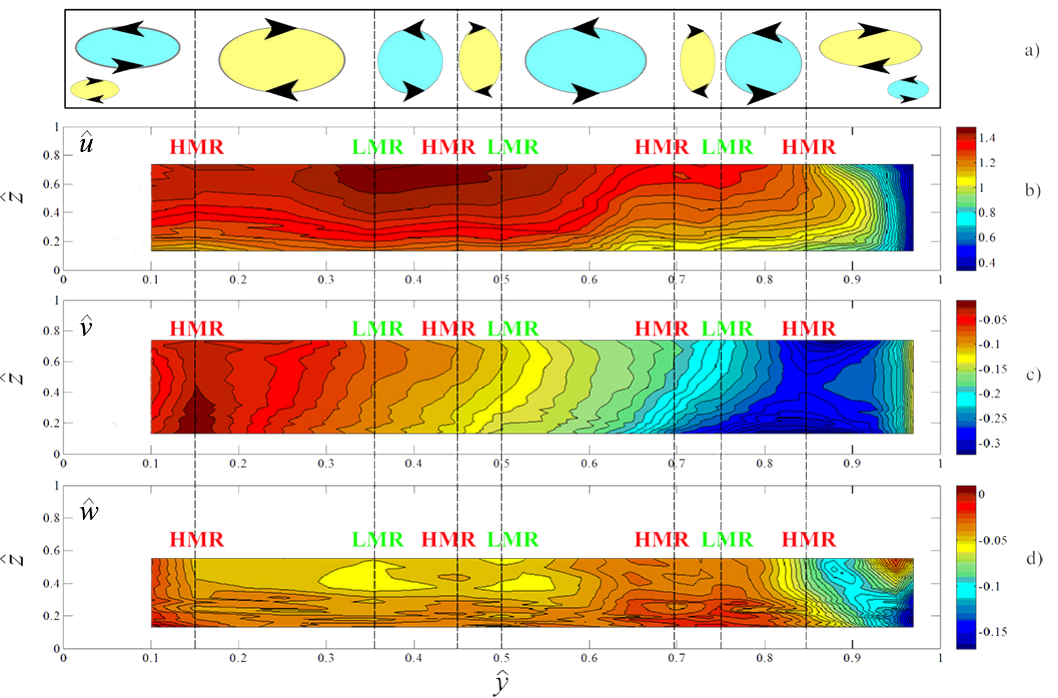
Figure 4. Patterns of some hydrodynamic variables at cross-section no. 2: ( a ) schematic of secondary currents; ( b ) normalized streamwise velocity component, ˆ u = ¯ u / U m 0 ; ( c ) normalized spanwise velocity